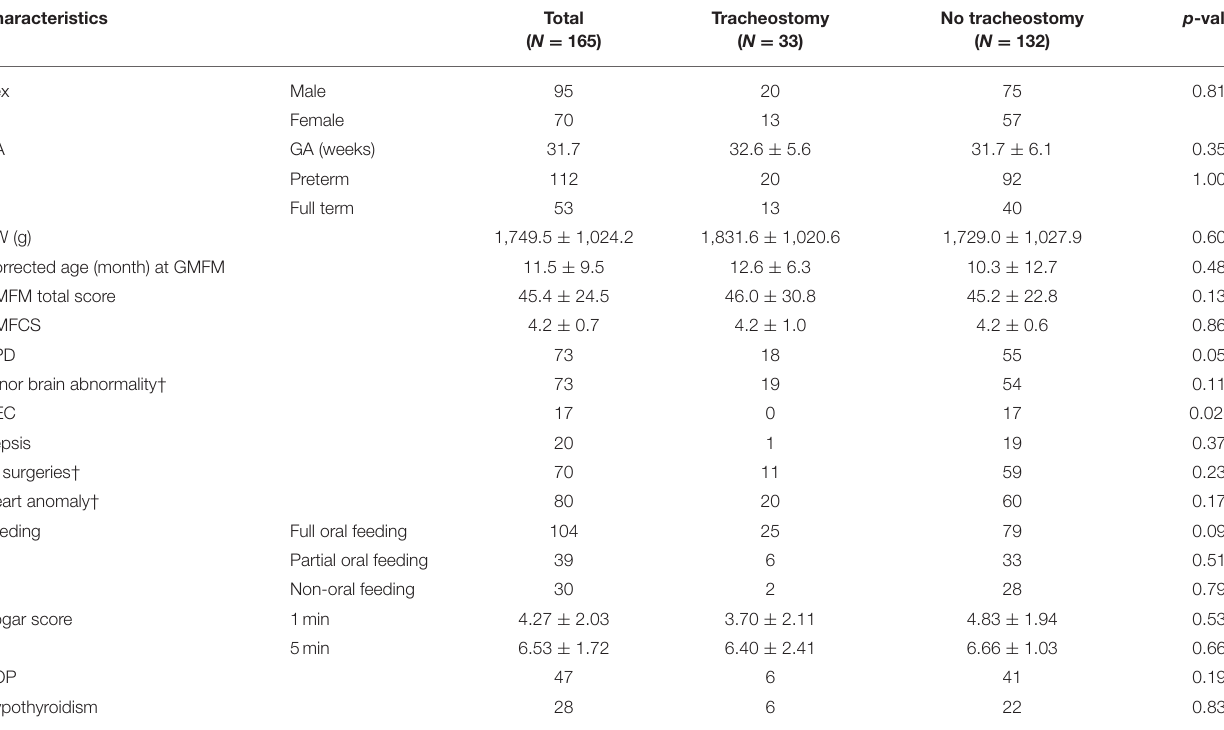
TABLE 1 | Demographic and developmental characteristics of